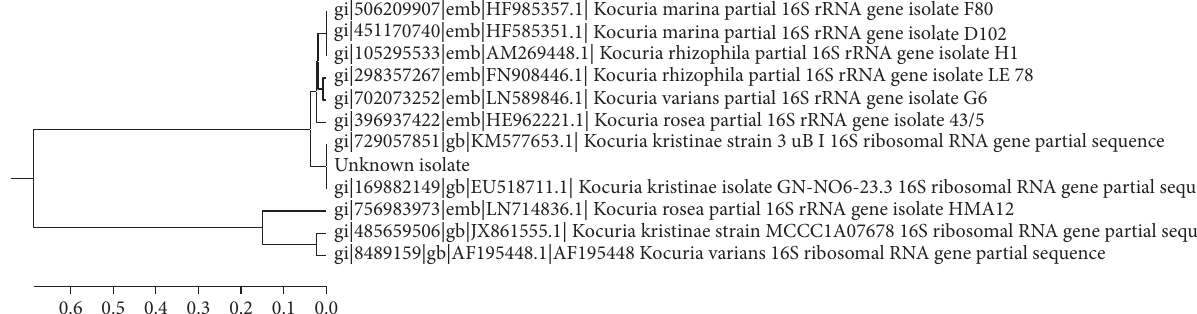
Figure 1: Evolutionary relationships of taxa. The evolutionary history was inferred using the UPGMA method